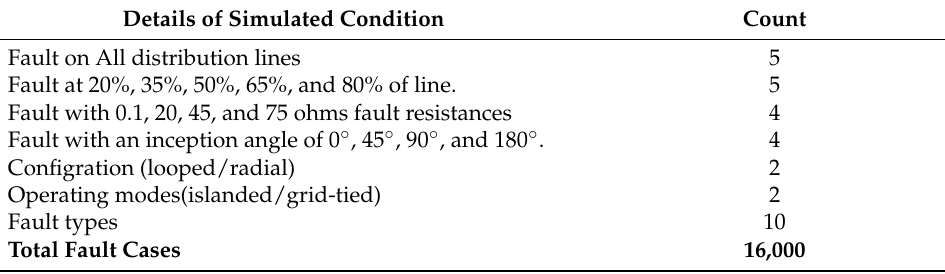
Table 1. Simulated fault scenarios on the IEC MG test system.